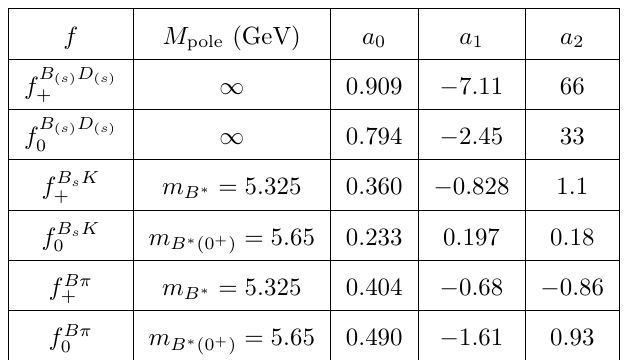
Table 12 . Best (cid:12)t parameters for the form factors (C.16) of B transitions